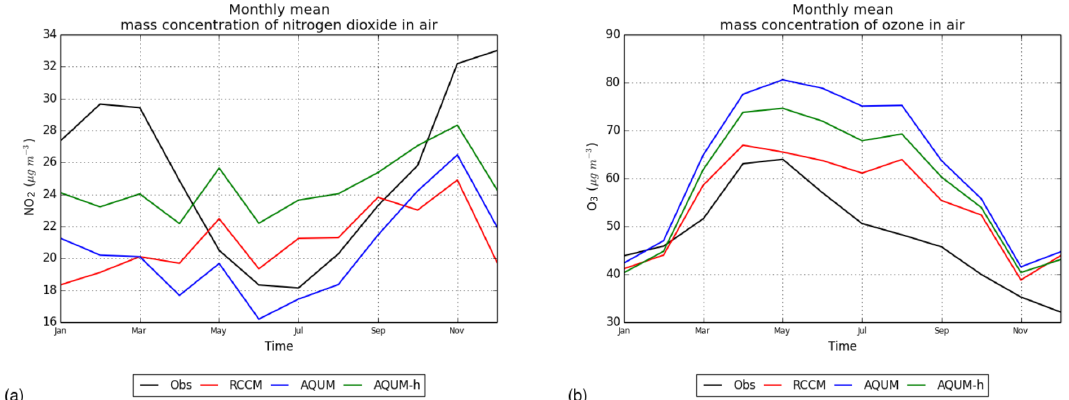
Figure 5. Monthly mean concentrations of (a) NO 2 and (b) O 3 . Observations are shown in black, RCCM in red, AQUM in blue, and AQUM-h in